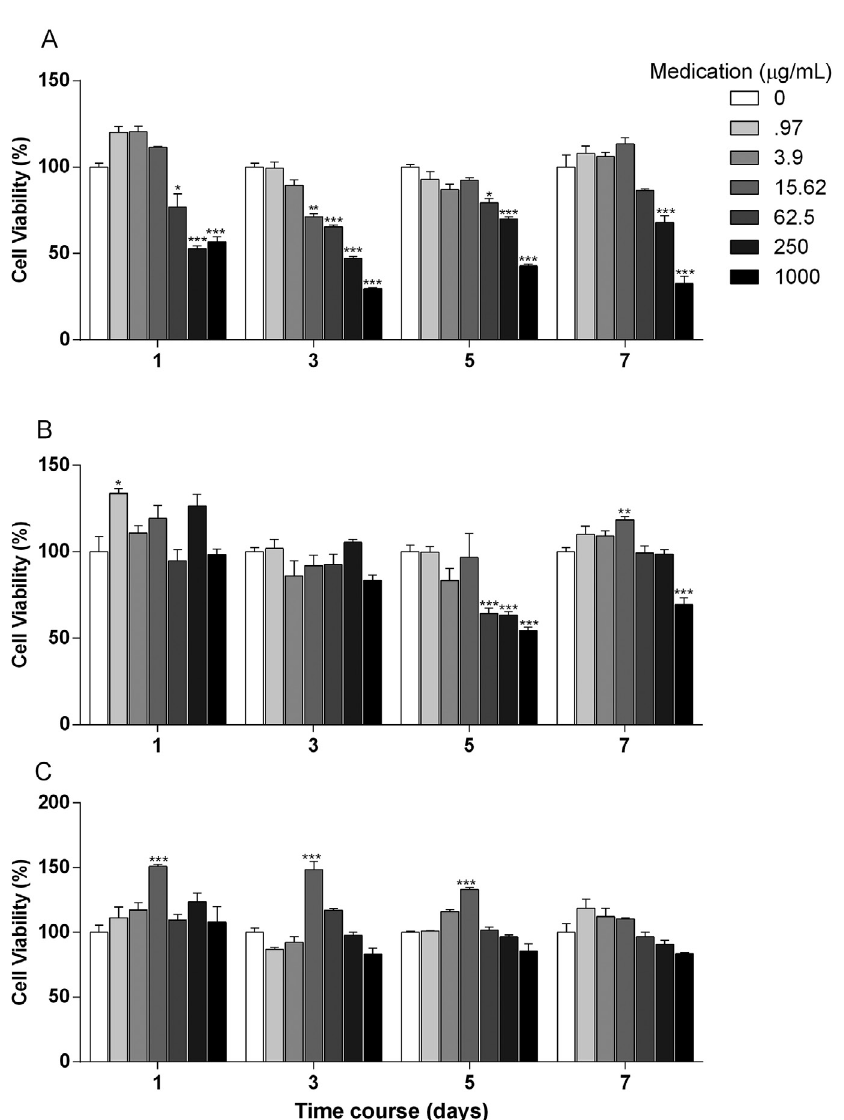
Figure 3- Cytotoxicity of antimicrobials on APC. In vitro cytotoxicity of mTAP (A), CMC (B) and mCMC (C) at indicated concentrations in contact with APC for 1, 3, 5 and 7 days. Cell viability detected by MTT assay and normalized based on control (untreated) cells. *p<.05, **p<.01, and ***p<.001 in comparison to culture medium alone (0)